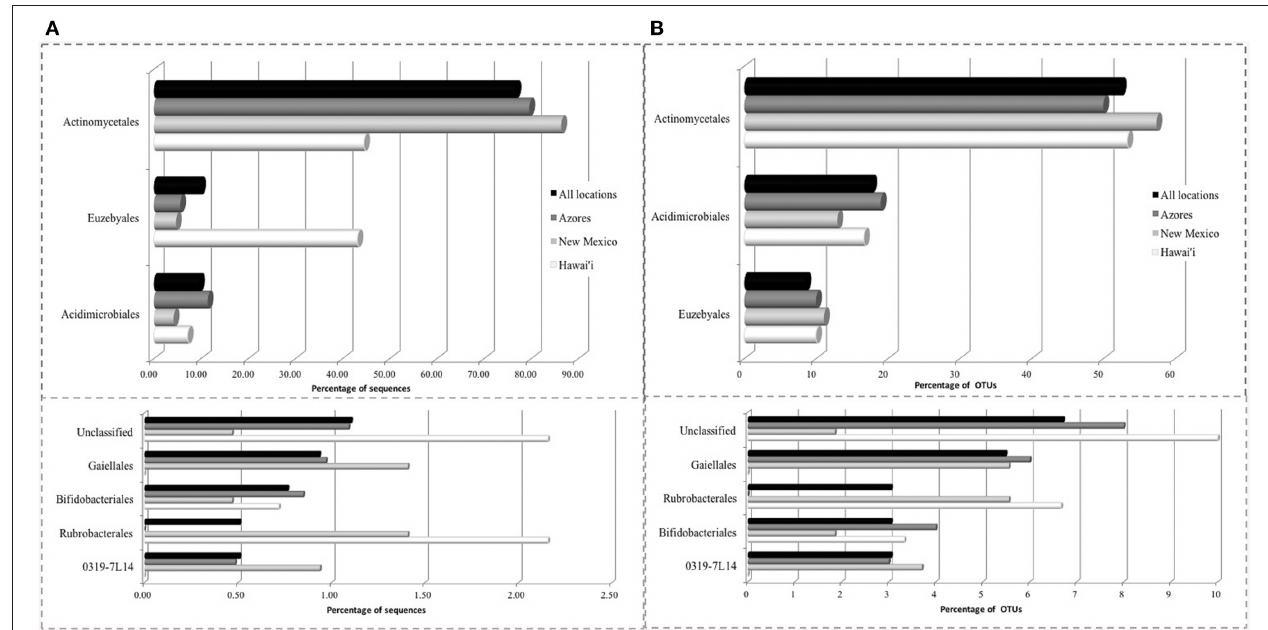
FIGURE 4 | Order-Level delineation of the 16S rRNA gene sequences (A) and OTUs (B) in Azores, New Mexico and Hawai`i lava